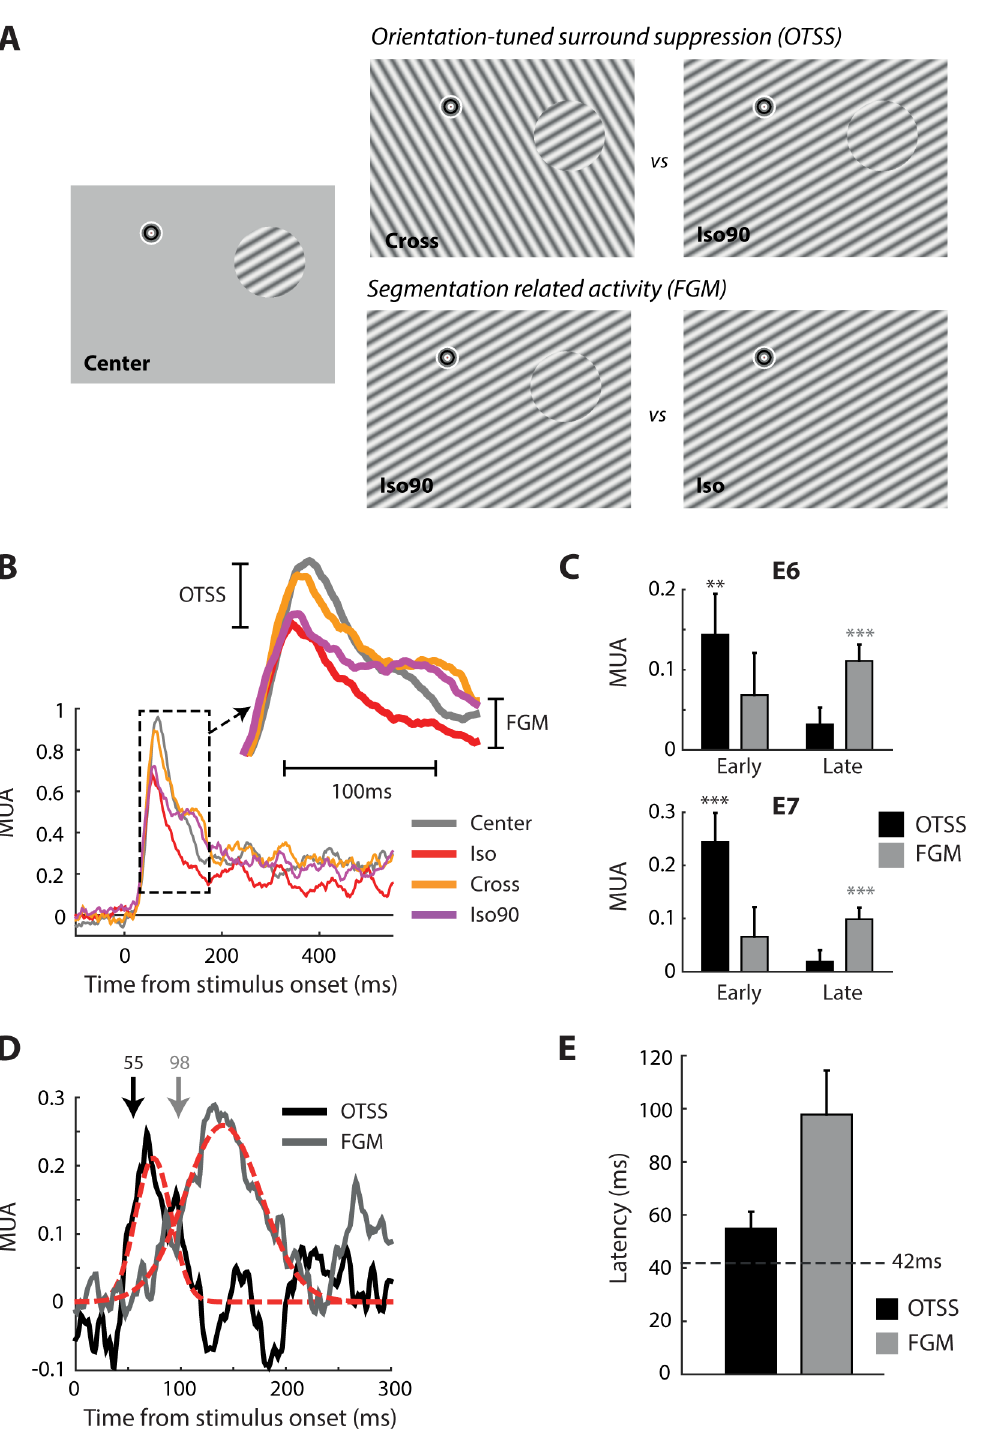
Fig 6. Contextual modulation of neuronal responses in human V2/V3. (A) The stimuli used to study contextual modulation. In the center-only condition, a 6° diameter grating was centered on the RF. We used two different orientations so that, on average, the orientation of the center was the same across conditions. In the Iso, Iso90, and Cross conditions, a full-screen surround was added. These conditions allowed extraction of signals related to two contextual effects: orientation-tuned surround suppression (upper panels) and figure-ground modulation (lower panels). (B) The MUA time courses averaged across E6 and E7. The inset shows responses during the early phase. These early responses were suppressed when the surround had the same orientation as the center (Iso, Iso90). Later activity depended on whether the central grating could be segmented from the background (Iso90, Cross) or not (Iso). (C)